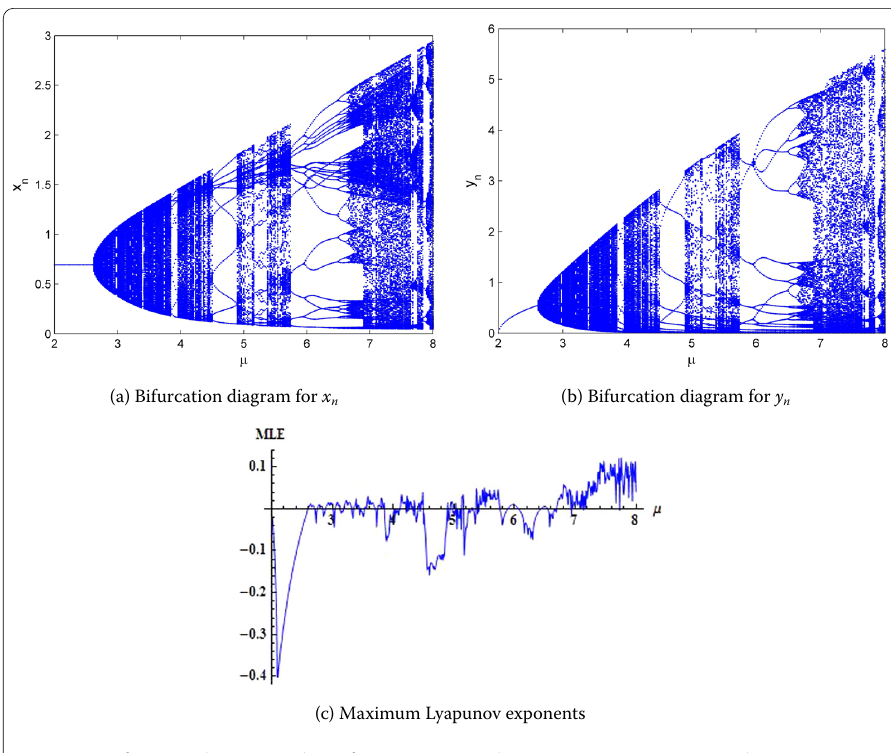
Figure 12 Bifurcation diagrams and MLE for system (1.5) with ν = 4.1, η = 1.5, μ ∈ [2,8], and ( x 0 , y 0 ) = (0.6956,0.5465)